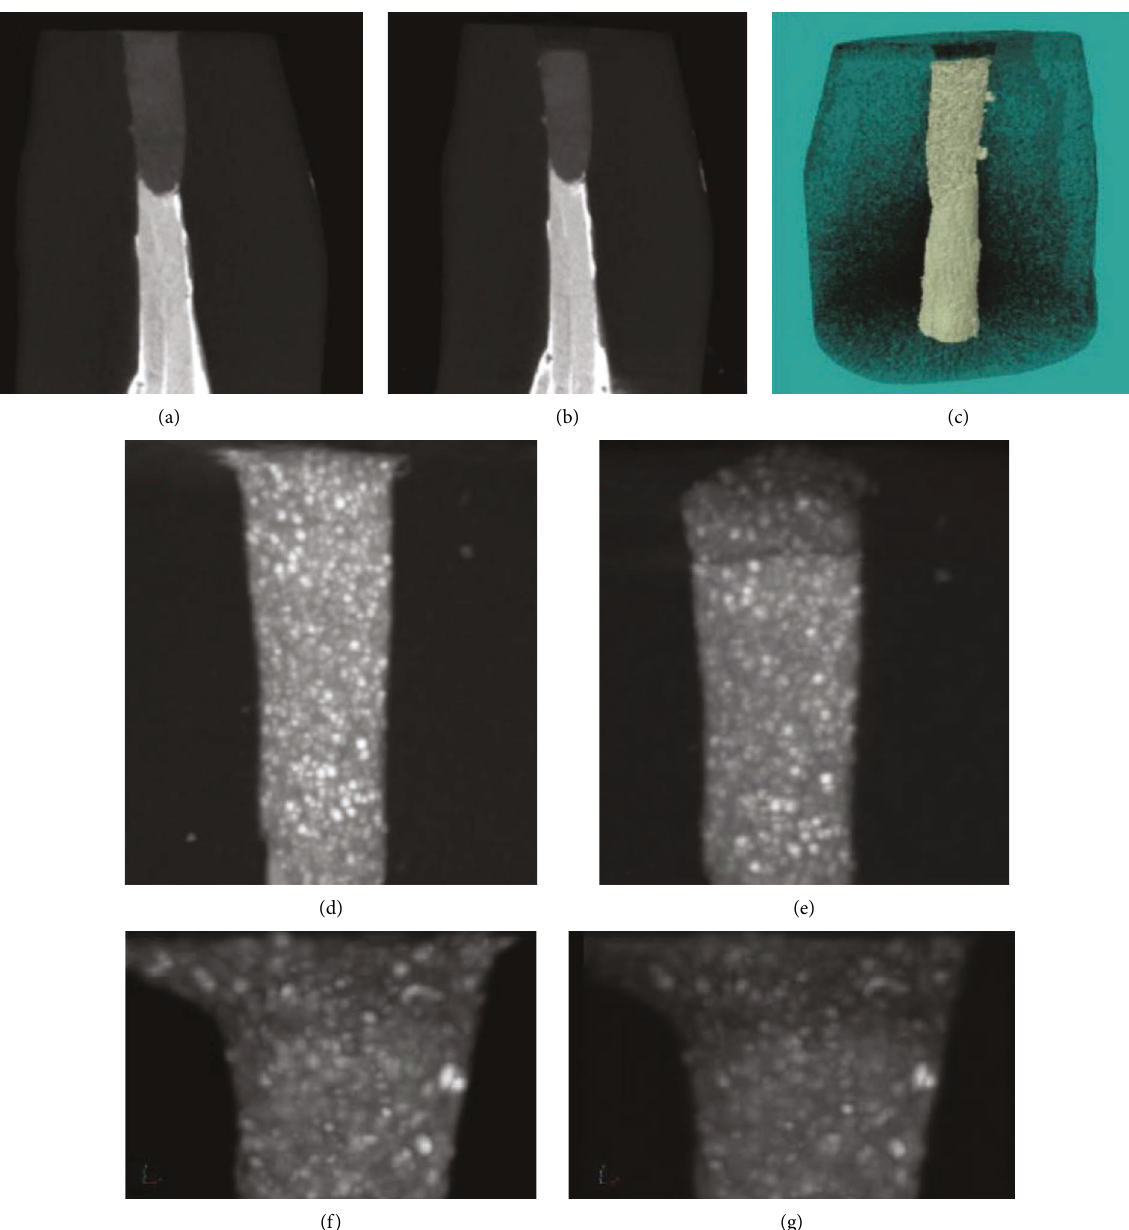
Figure 4: The volume change of Biodentine in acidic pH. Before scanning with micro-CT, Biodentine was fully set on the retrograde cavity (a). The volume loss after exposure to acidic pH (b, c). Density variation of ProRoot MTA observed by the CTVox programme. Before and after exposure to the acidic medium (d, e). A loss of density was observed. After exposure to acidic pH, internal changes in MTA Angelus were observed by the CTVox programme. In acidic pH, larger particles converted into smaller ones, which increased the gaps (f,